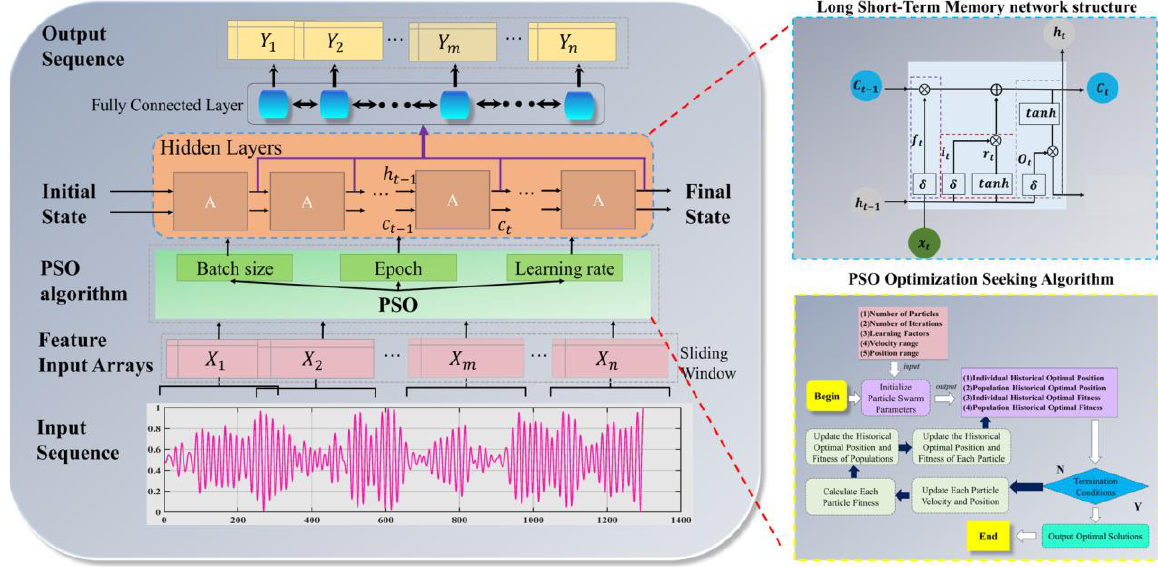
Figure 3. PSO – LSTM model algorithm flowchart. Finding parameters (batch size, epoch, learning rate) of LSTM network structure by particle swarm algorithm.